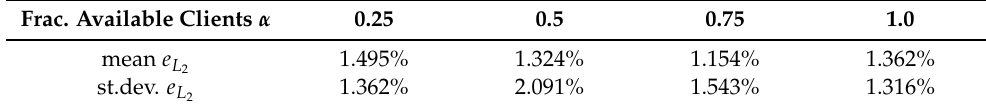
Table 2. The mean and standard deviation of the L 2 -relative errors computed when predicting with Random Field and variable fraction of available clients within the set α ∈ { 0.25,0.5,0.75,1.0 } . Frac. Available Clients